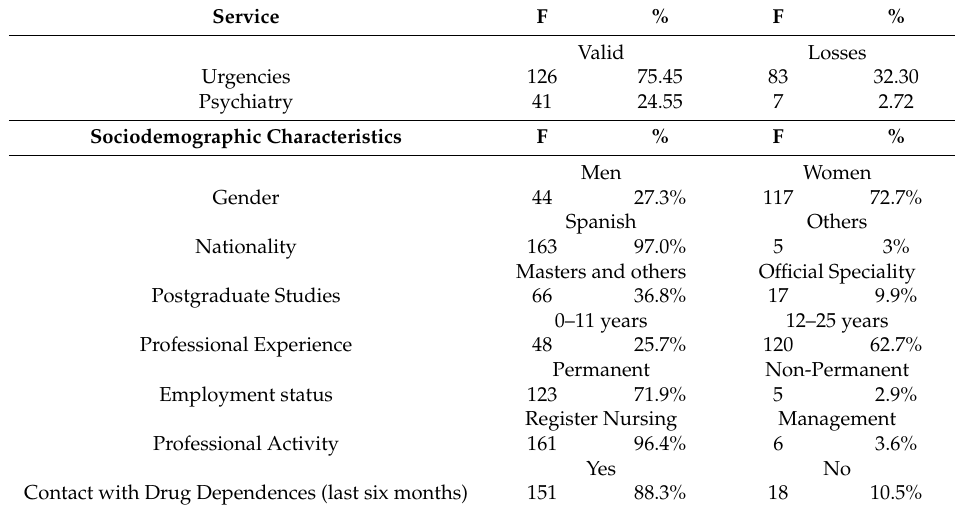
Table 1. Distribution of the sample according to sociodemographic characteristics.